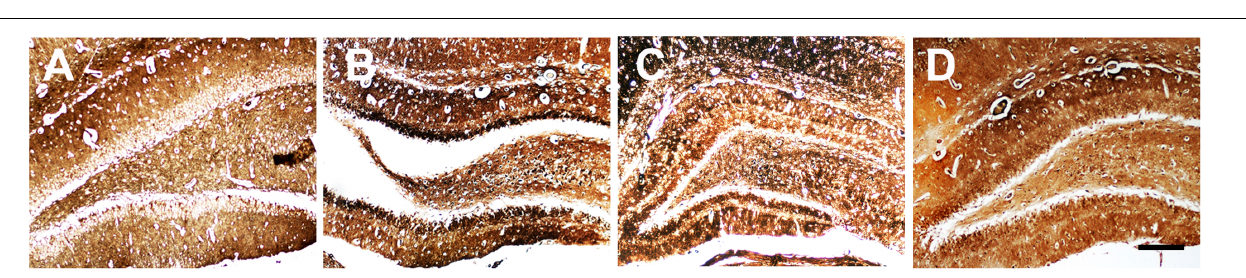
FIGURE 2 | Timm’s staining of zinc-containing mossy fiber terminal fields in hippocampal CA3 region in the (A) control, (B) SE, (C) Scr and (D) Ant-134 groups. Scale bar: 100 µ